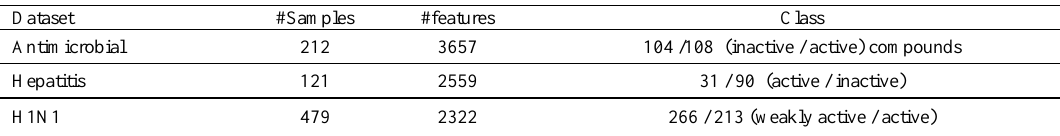
Table 1. Description of the used datasets